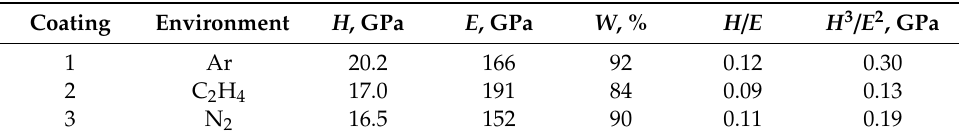
Table 2. Mechanical properties of coatings.